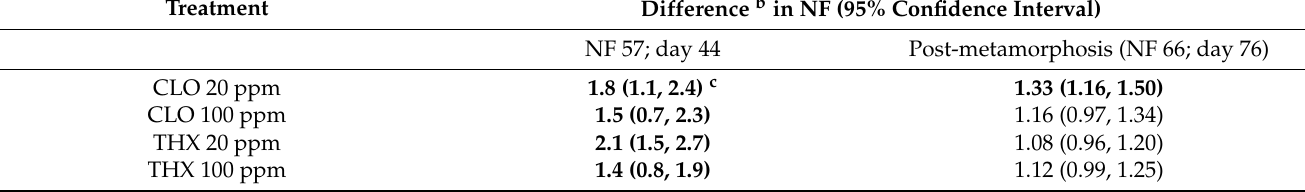
Table 4. Comparison of Xenopus laevis tadpole development a in treatment groups compared with controls in neonicotinoid- free media as measured on day 44 and on day 76. Tadpoles were exposed to low or high concentrations of clothianidin (CLO) and thiamethoxam